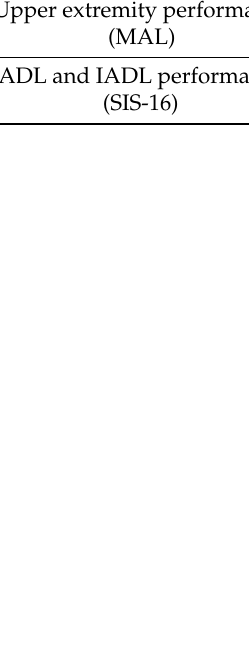
Table 3. Correlations between function and performance variables at baseline (overall group, n =